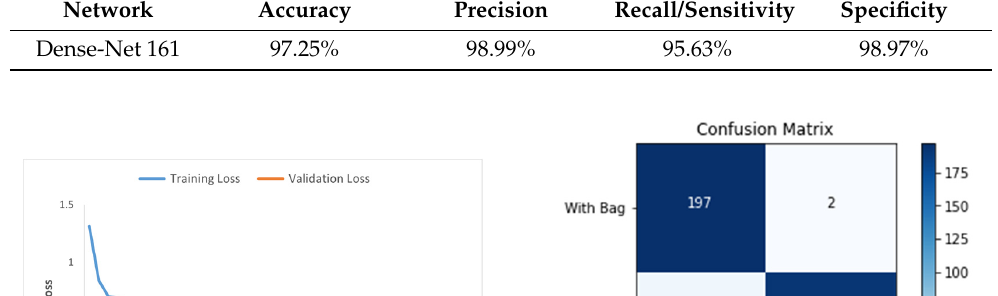
Table 7. The evaluation results of the second experiment on INRIA and MSMT17 datasets. Network